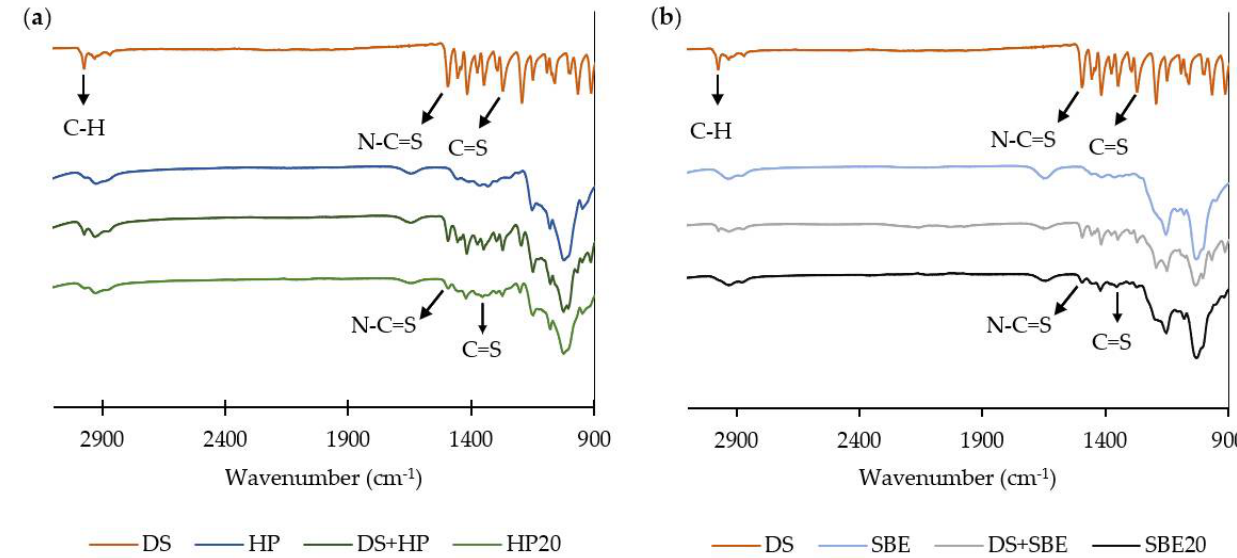
Figure 6. Fourier Transform Infrared Spectroscopy (FTIR) spectra of ( a ) DS, physical mixture of DS with HP-CD, raw HP-CD, and HP-CD freeze-dried formulation; ( b ) DS, physical mixture of DS with SBE-CD, raw SBE-CD, and SBE-CD freeze-dried formulation.